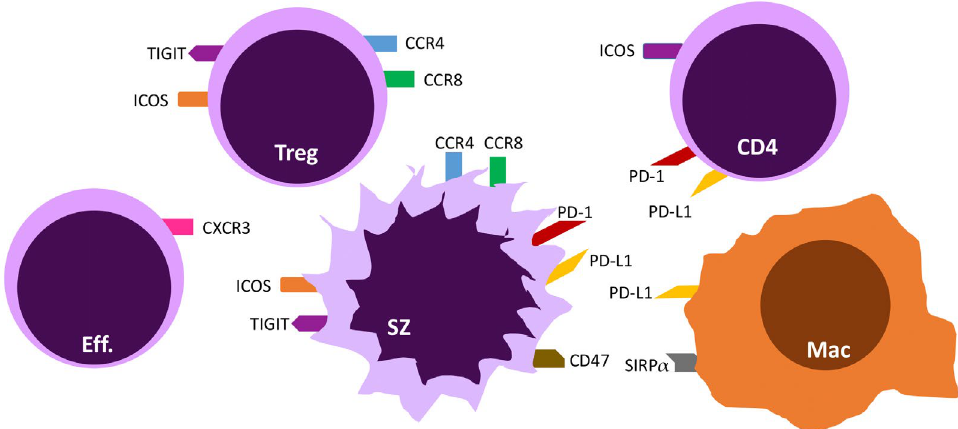
Figure 2. Main targetable immune checkpoints in mycosis fungoides and Sézary syndrome. The figure shows selected targetable immune checkpoints in mycosis fungoides and Sézary syndrome.